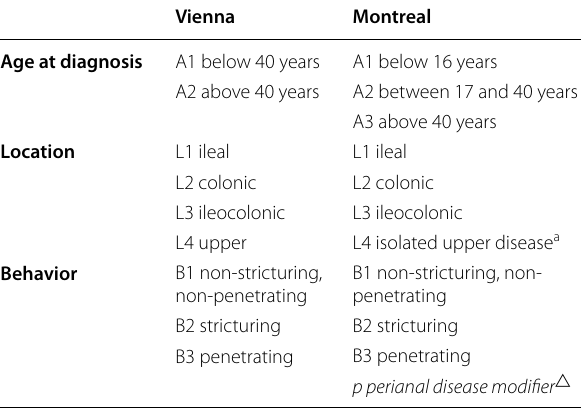
Table 3 Vienna and Montreal classification for Crohn’s disease